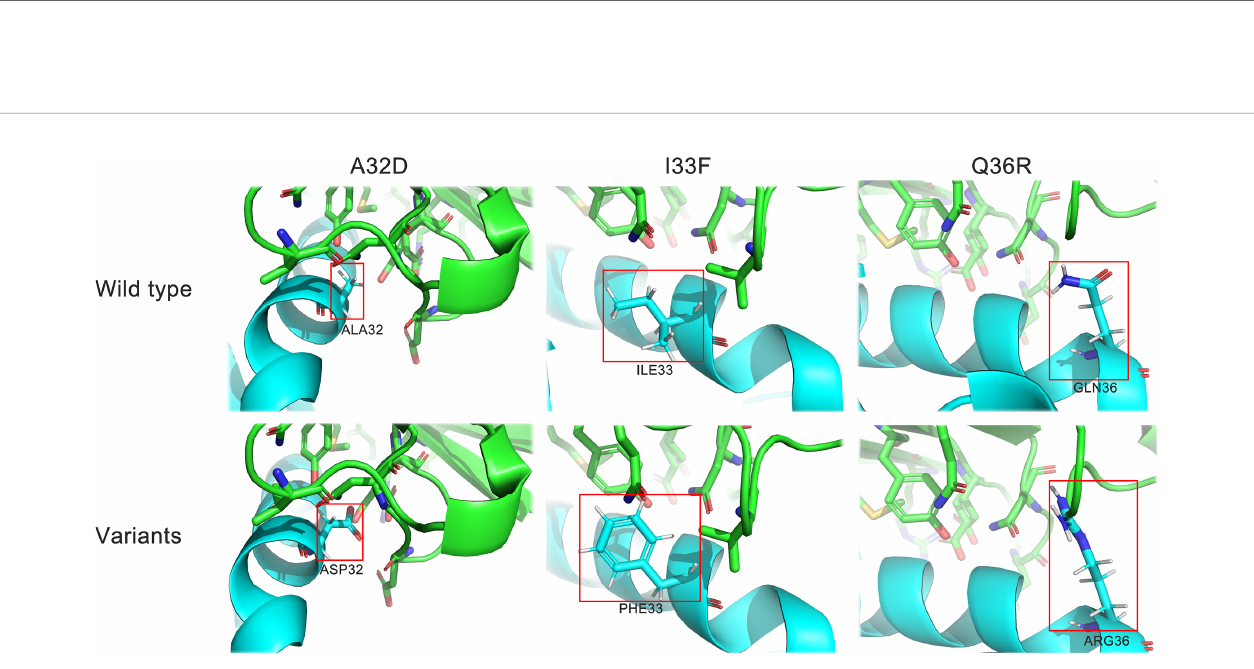
FIGURE 5 | Anti-melanoma ef fi cacy of rU1 snRNPA in a melanoma – human immune system immunode fi ciency mouse model. (A) Survival rates of rU1 snRNPA or durvalumab. (B) Tumor volume changes measured over time in different groups ( n = 10).